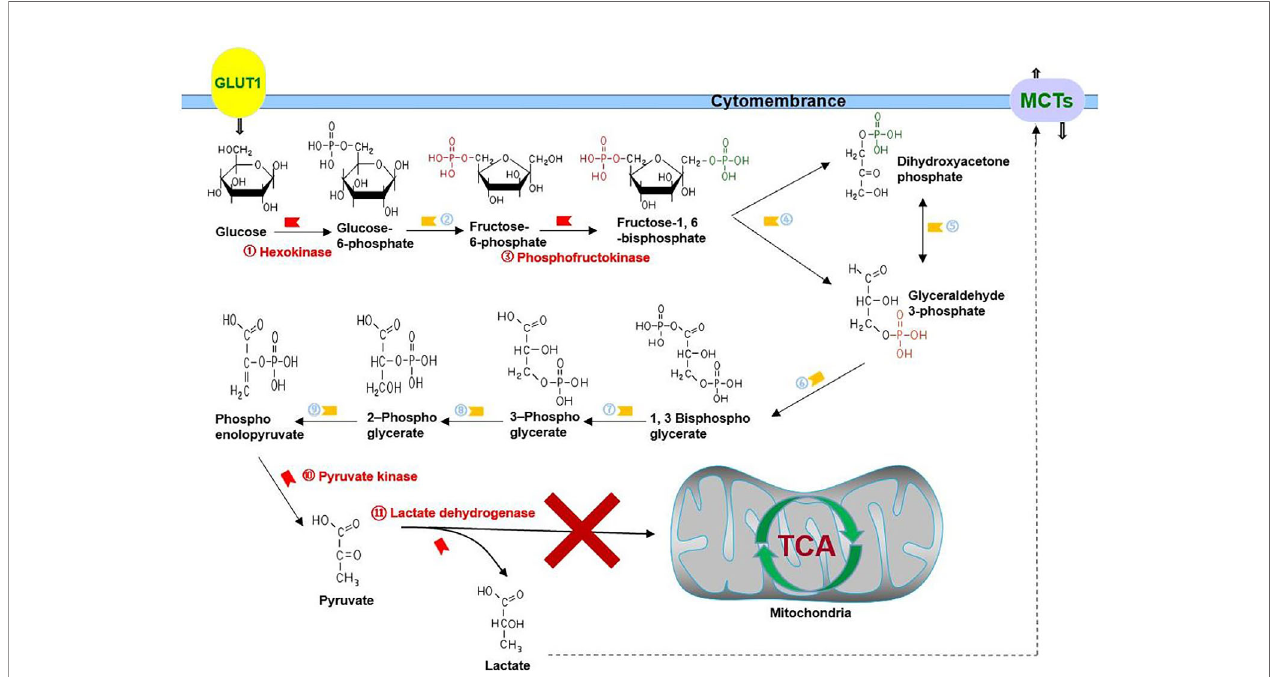
FIGURE 1 | Glycolysis in cancer: cancer cells choose glycolysis as their primary energy source even under normoxia, which means pyruvate is mainly converted into lactate to play its role in energy source, rather than being incorporated into the TCA cycle. GLUT1 is responsible for transporting glucose, and MCTs are responsible for transporting lactate. ② , phosphohexose isomerase; ④ , aldolase; ⑤ , triose phosphate isomerase; ⑥ , glyceraldehyde 3-phosphate dehydrogenase; ⑦ , phosphoglycerate kinase; ⑧ , phosphoglycerate mutase; ⑨ ,